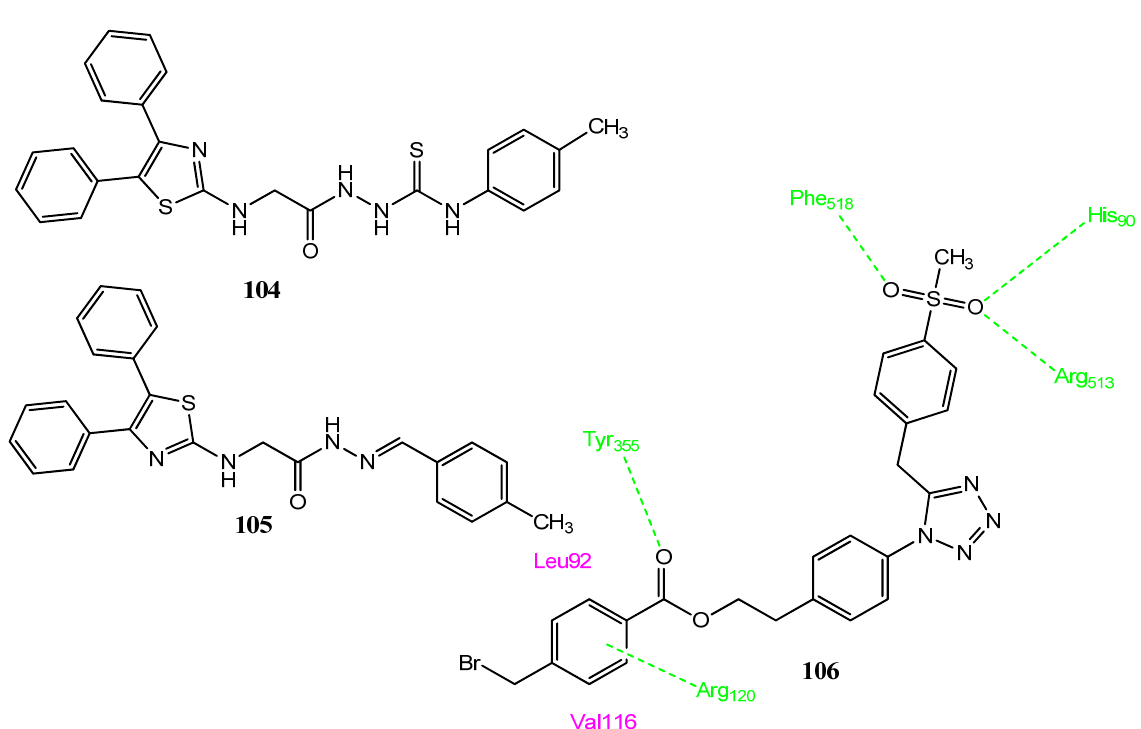
Figure 20. Imidazolone and triazole derivatives.